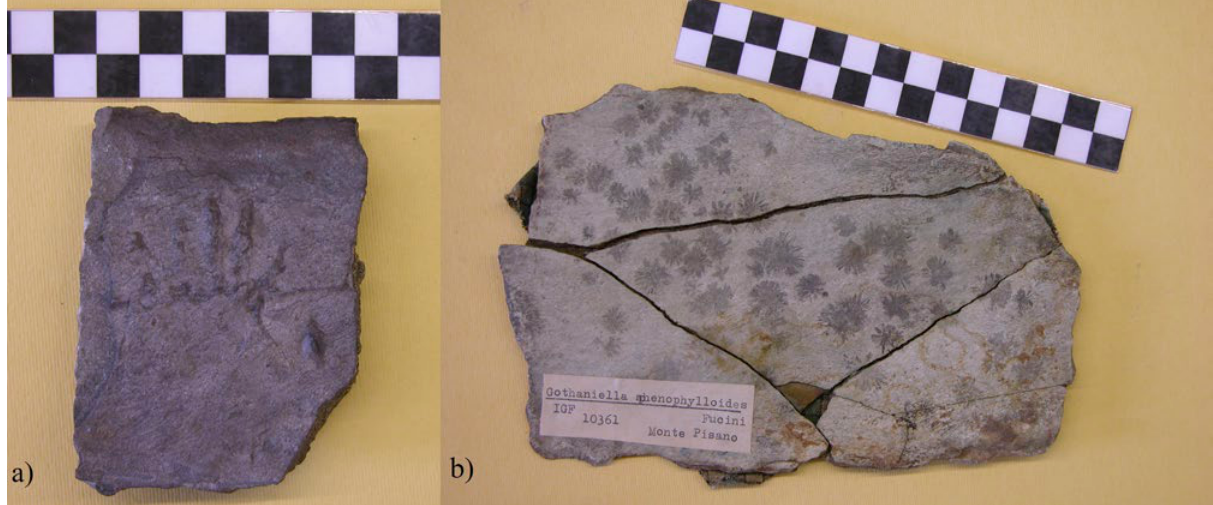
Figure 1. Examples of animal and vegetal finds of Fucini Collection: find IGF 5152, a) hand-print of a small carnivorous reptile: The codon- tiehnus verrucae; b) IGF 1036, a fossil seaweed: Gothaniella sphenophylloides